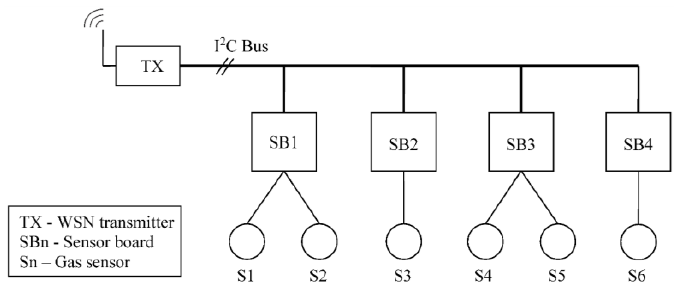
Figure 3. Transmitter-sensor interfacing.